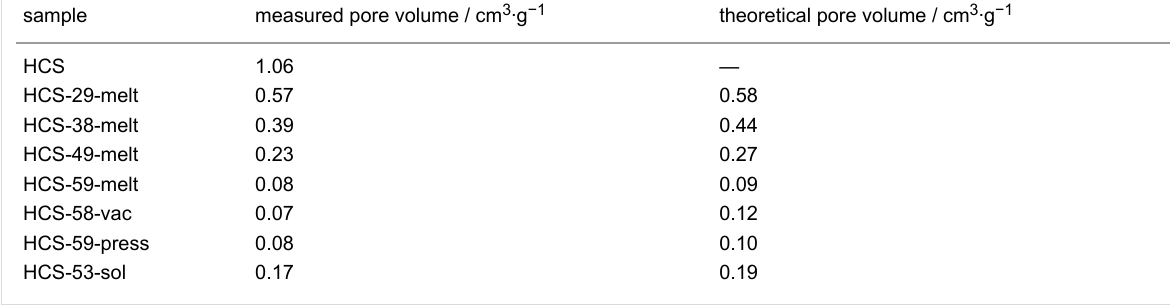
Table 2: Pore volume of HCS and HCS/sulfur composites measured by nitrogen physisorption and theoretical pore volume of the composites calcu- lated from the pore volume of HCS and the volume of the impregnated amount of sulfur.